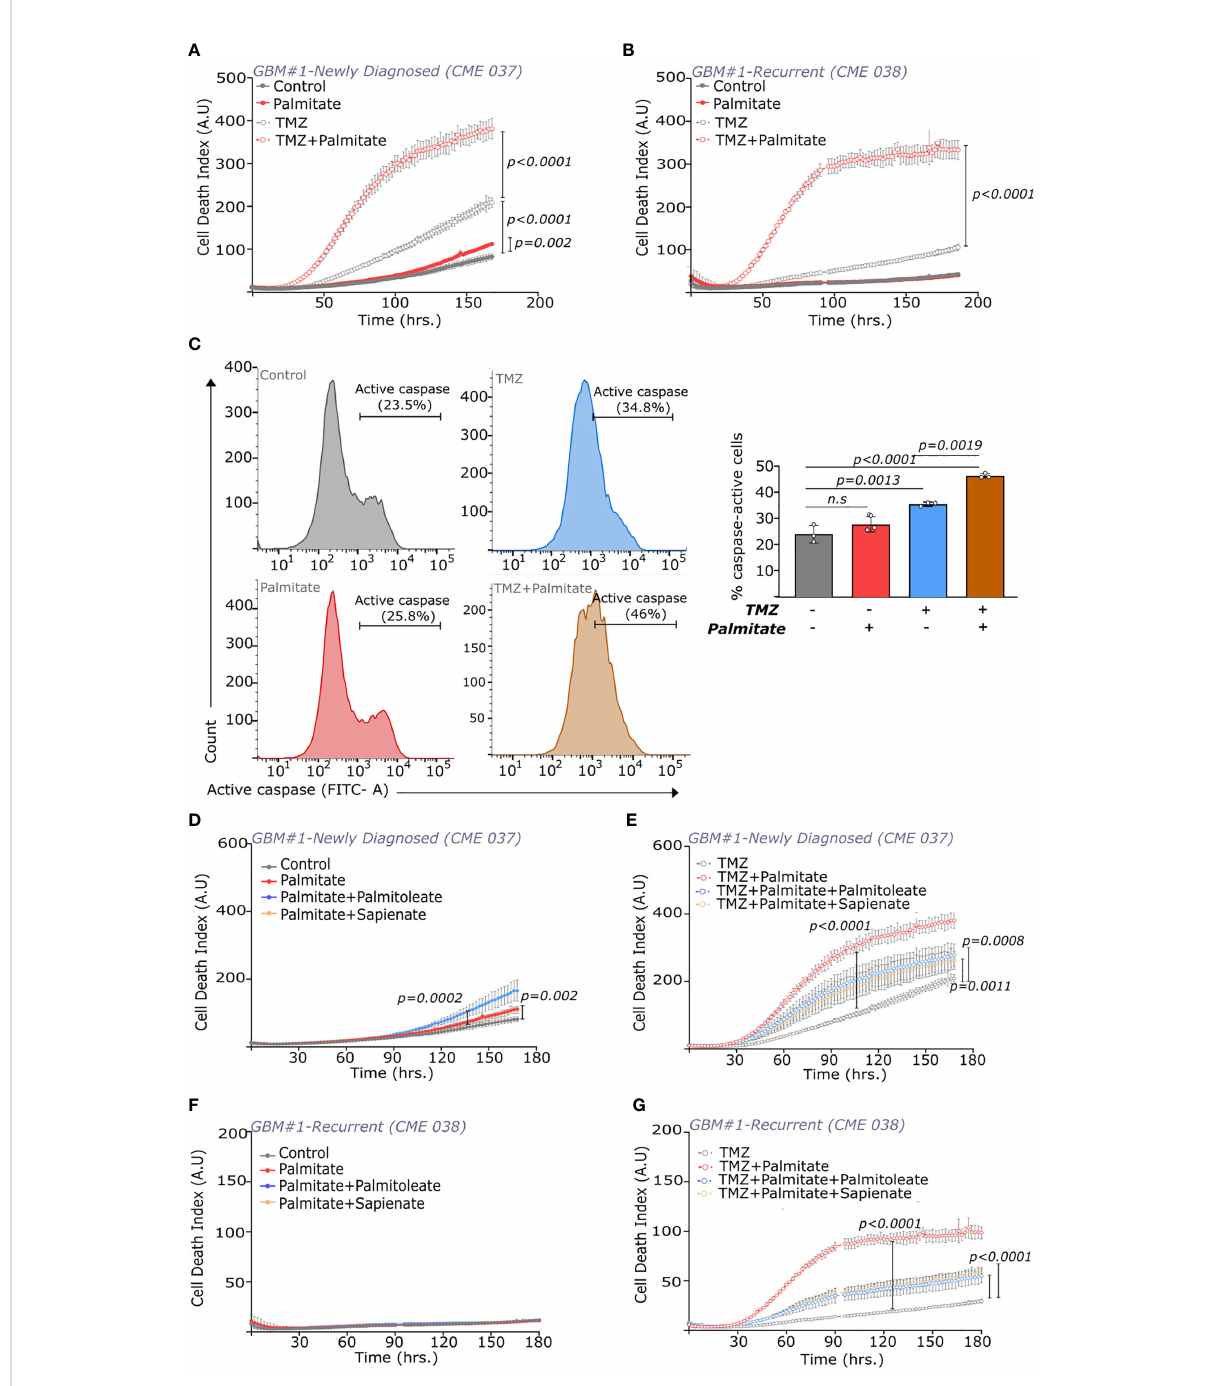
FIGURE 4 Palmitatein fl uencestemozolomideef fi cacyinnewlydiagnosedandrecurrentGBMs. (A,B) Celldeathindex(numberofdeadcells/con fl uence)overtimein (A) newlydiagnosed(CME037)and (B) recurrent(CME038)cellsfromGBM#1with±TMZ(250 m M)and±palmitate(100 m M).Statisticalanalysiswas performedusingTwo-wayANOVAwithrepeatedmeasuresandSidak ’ smultiplecomparison=5. (C) CellEvent ™ Caspase-3/7basedFACSanalysisof caspase-activepopulation(FITC+ve)inrecurringGBMcells(CME038)fromGBM#1(left)Cellcountsvs.FITCintensityincellswith/withoutTMZ(250 m M) andpalmitate(100 m M)(right)QuantitationofthepercentageofFITC+vecells(caspase-active)with/withoutTMZ(250 m M)andpalmitate(100 m M).TMZ treatmentwasdonefor4days,followedby2daysofTMZ±palmitate.Statisticalanalysiswasperformedusingone-wayANOVAwithTukey ’ smultiple comparison.n=3. (D,E) Celldeathindex(numberofdeadcells/con fl uence)overtimeinnewlydiagnosed(CME037)cellsfromGBM#1 (D) withoutor (E) withTMZ(250 m M)and±palmitate(100 m M),±sapienate(100 m M)or±palmitoleate(100 m M).StatisticalanalysiswasperformedusingTwo-wayANOVA withrepeatedmeasuresandSidak ’ smultiplecomparison.n=5. (F,G) Celldeathindex(numberofdeadcells/con fl uence)overtimeinrecurrent(CME038) cellsfromGBM#1 (F) withoutor (G) withTMZ(250 m M)and±palmitate(100 m M),±sapienate(100 m M)or±palmitoleate(100 m M).Statisticalanalysiswas performedusingTwo-wayANOVAwithrepeatedmeasuresandSidak ’ smultiplecomparison.n=5.n.s,notsigni fi